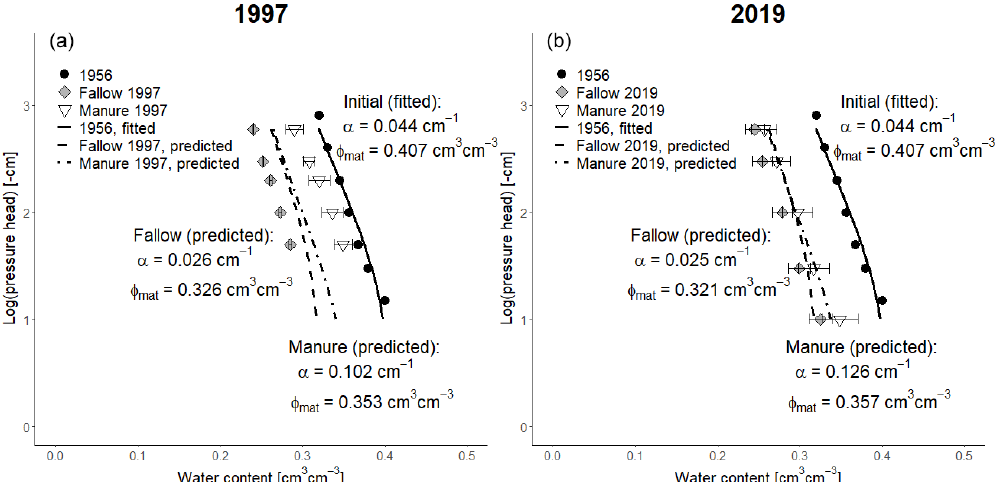
Figure 9. Observed (symbols; bars show standard deviations) and simulated (dashed and dotted lines) soil water retention curves in the fallow and animal manure treatments using Eqs. (26) and (27). (a) Measurements taken in 1997, and (b) the measurements taken in 2019. The measurements used as the initial condition in 1956 are also shown, together with a fitted curve. Van Genuchten’s n was fixed at 1.073 for all water retention curves.